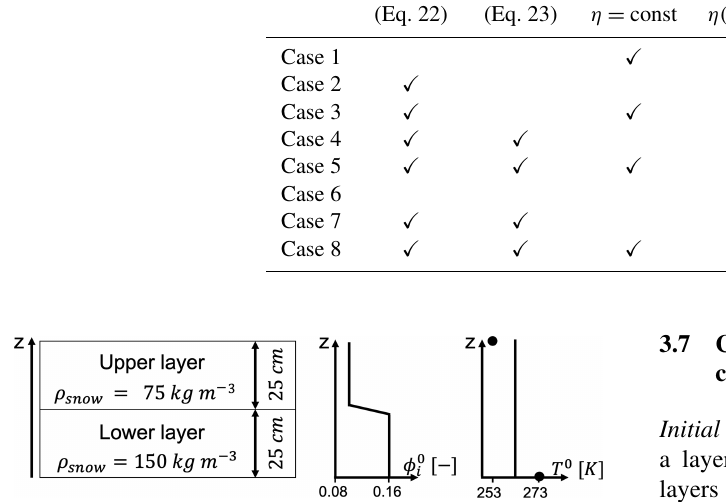
Figure 3. The initial condition of the snowpack regarding snow den- sity on the left-hand side and profile plots of the initial ice volume fraction ( φ 0 ) and temperature ( T 0 ) on the right-hand side. There are i two snow layers with equal thickness of 25cm, yielding a snow- pack of 50cm height. The bottom layer has a higher density of 150kgm − 3 , and the upper layer’s density is 75kgm − 3 . The z axis of the 1D model increases in an upward direction, so z = 0 denotes the ground. Downward-directed movements are thus described by negative velocities. The vicinity of the interface between the two layers is referred to as the transition area. The initial ice volume fraction is derived from the initial snow density. Its profile ( φ 0 shows the linear decrease over 2cm of the ice volume fraction in the transition area from the lower to the upper layer. The initial tem- perature profile ( T 0 ) is constant at 263K. The black dots mark the constant temperature boundary conditions: 273K at the bottom and 253K at the